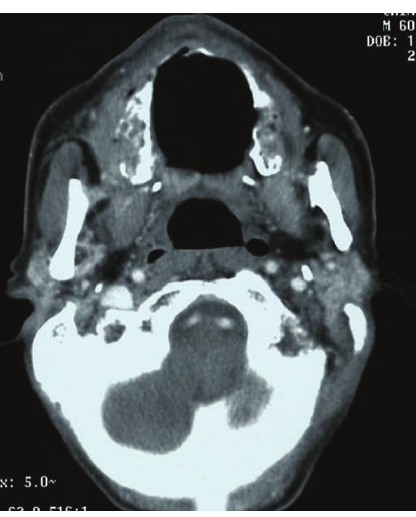
Figure 7: Despite a decrease in tumor size, soft tissue shadows remained and the evaluation was clinical PR. over were seen in the 2 patients who received this therapy, suggesting that it might represent an acceptable